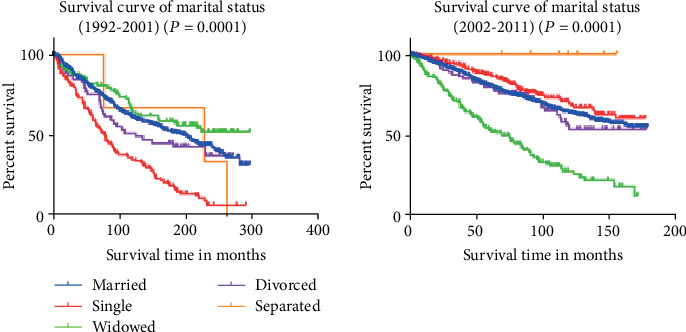
Kaplan-Meier estimate of overall survival as a function of marital status in the 1992-2001 and 2002-2011 patient cohorts.